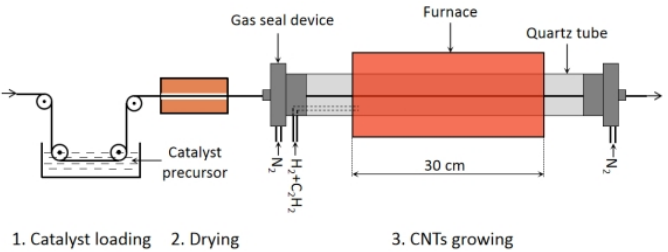
Figure 1. Schematic diagram of catalyst loading and carbon nanotubes (CNTs) growth equipment. Carbon fibers were driven by pulleys running at a directional and uniform speed.